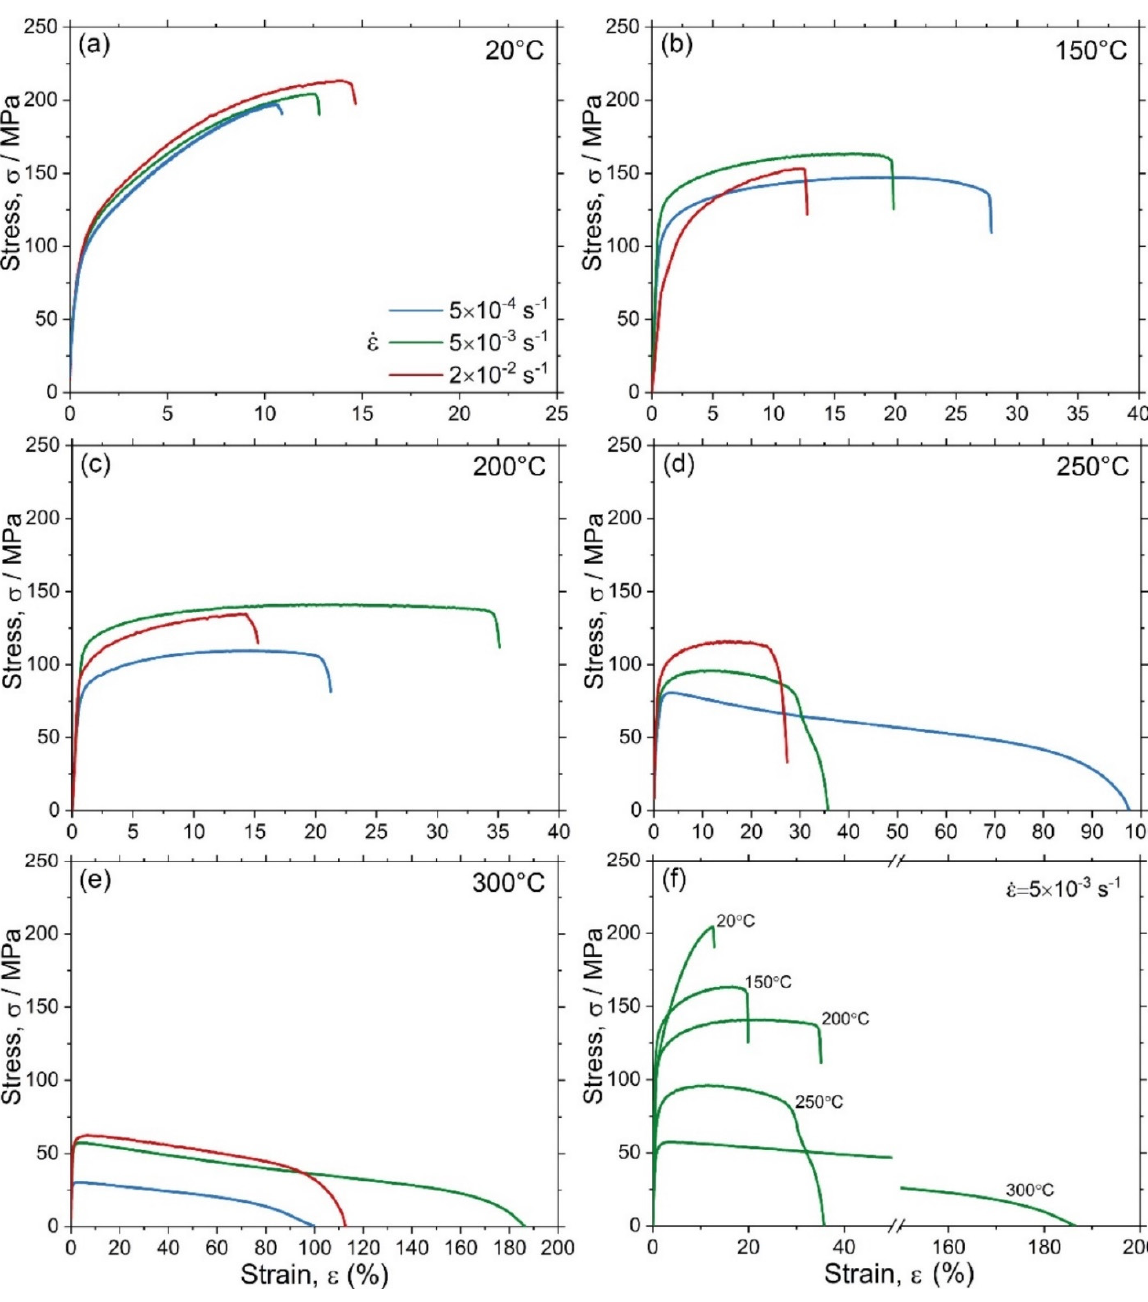
( ) σ ε curves obtained at ε 